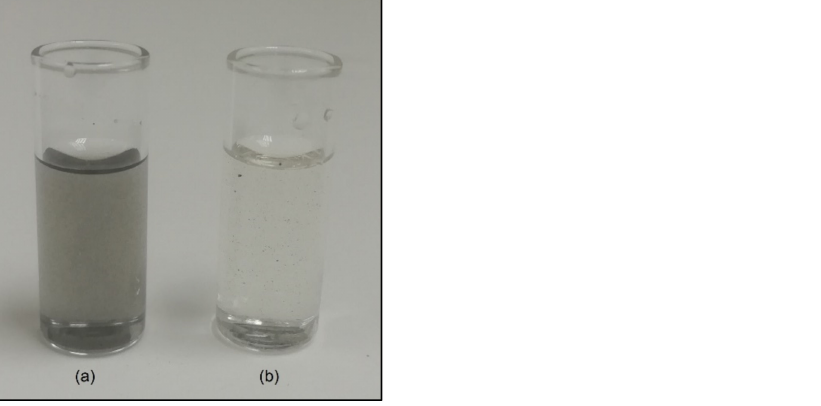
Figure 5. Pyr-PCL DMF solution + GNP ( a ), neat DMF + GNP ( b ); both after bath sonication for 1 h and 24 h of sedimentation. Quantity used: 3 mL of DMF, 50 mg of polymer and 5 mg of